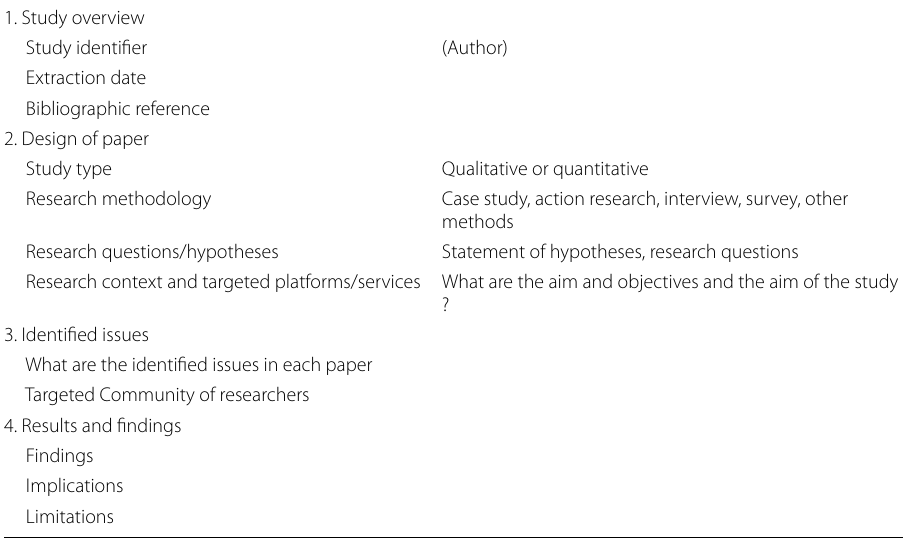
Table 4 Data extraction